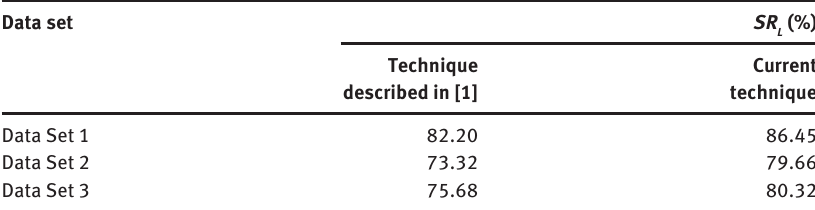
Table 2. Performance Comparison of the Piecewise Waterflow Technique with Earlier Work [1].